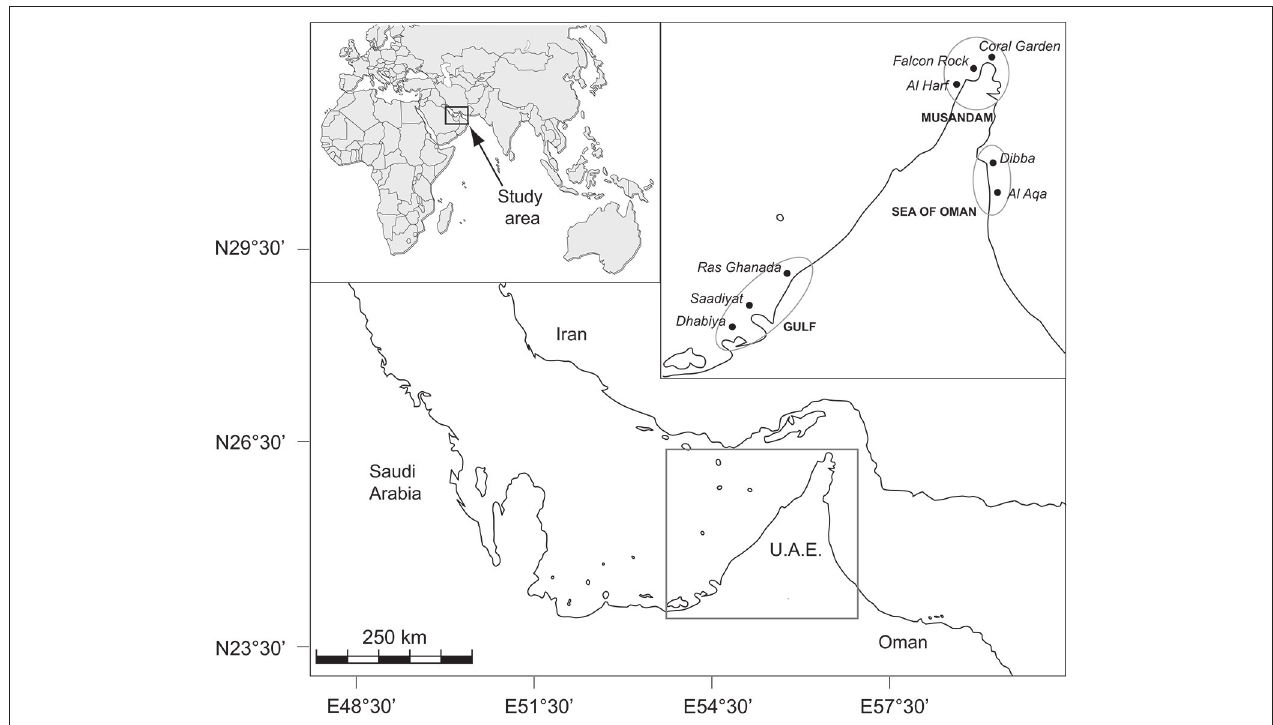
FIGURE 1 | Map of northeastern Arabian Peninsula indicating the location of study sites within each of the three